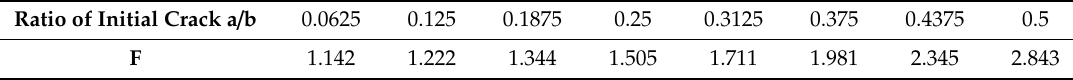
Table 2. Stress intensity factors F for di ff erent plate